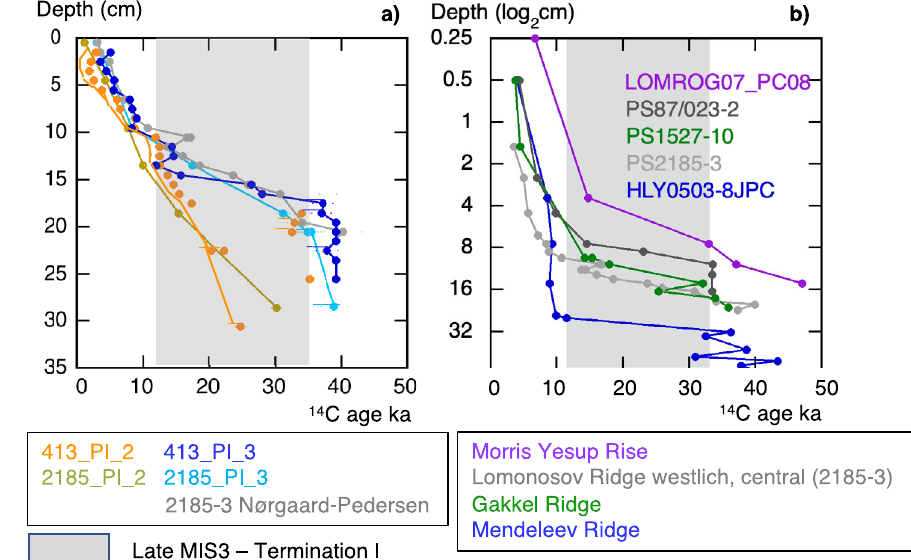
Fig. 7 Comparative radiocarbon ages and their implication for the assumption of missing late glacial sediments. a PI_2 and PI_3 specimens in the analyzed cores vs published data. b Exempli fi ed radiocarbon records from the Mendeleev, Lomonosov Ridge and Morris Yesup Rise (see also Supplementary Fig. 1). See the almost linear age development downcore of PI_2 specimens and the distinct age jump of PI_3 specimen and published records in glacial